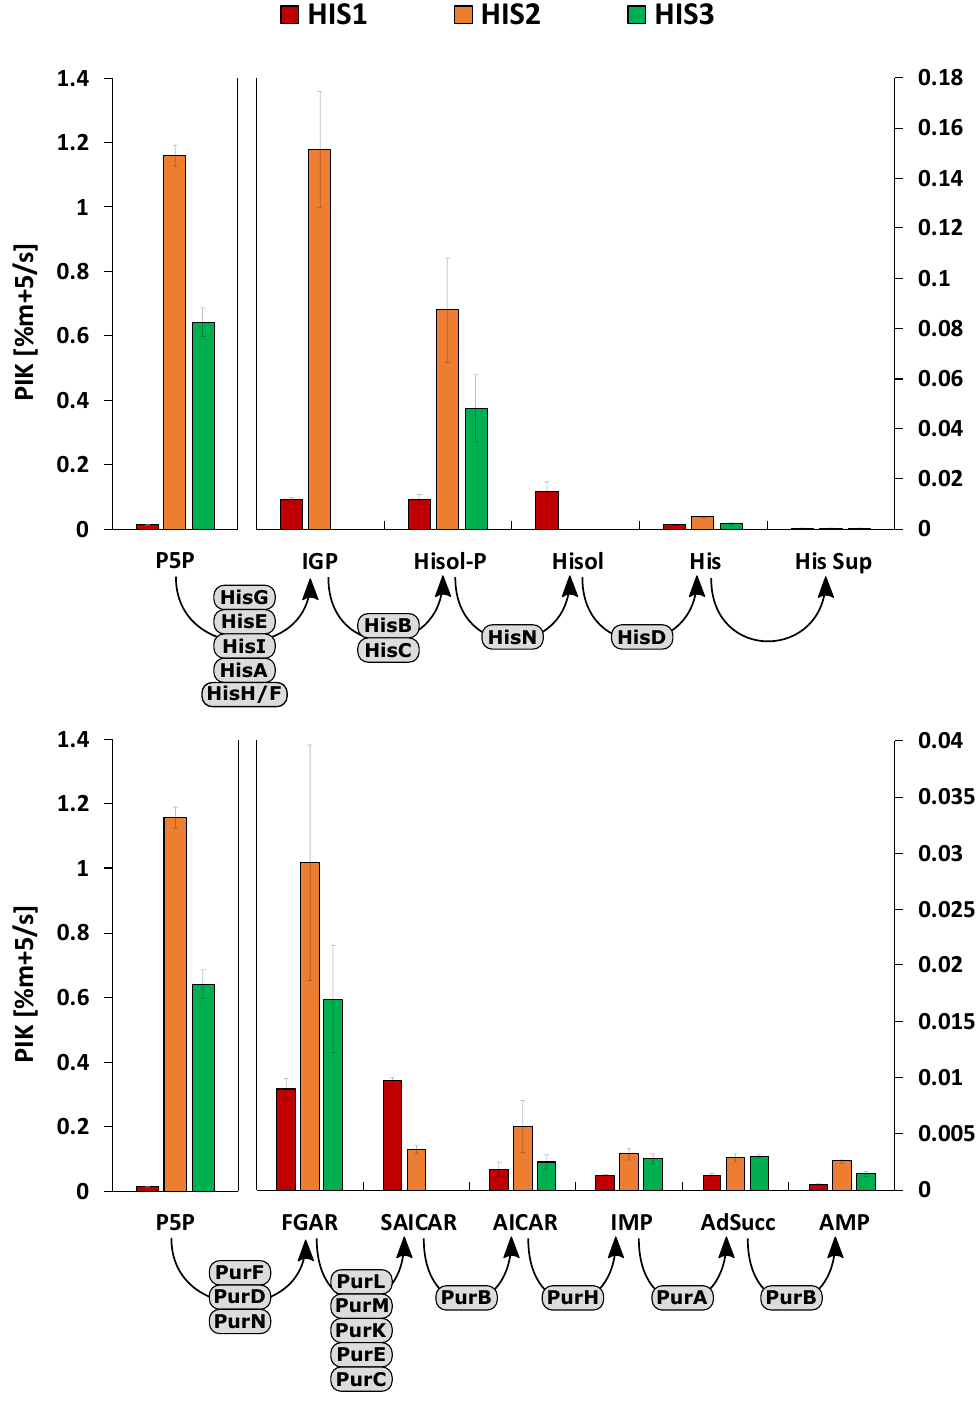
Figure 6. Pool influx kinetics (PIK) of measured metabolites in the l -histidine biosynthesis ( upper ) and purine biosynthesis ( lower ). Standard deviations are given as error bars. Corresponding enzymes are depicted in grey. PIK values were based on the experiments of three biological replicates ( n =